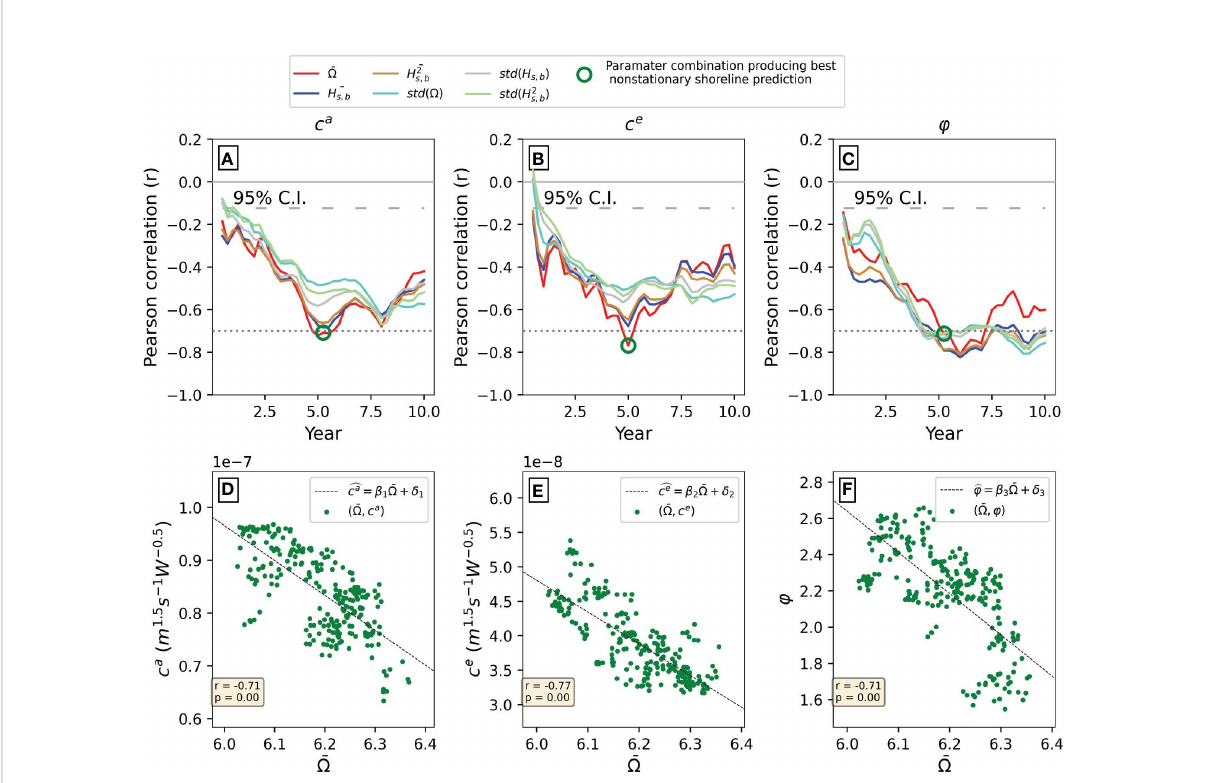
FIGURE 4 Summary results from Step 2 (Correlation analysis) and Step 3 (Parameterization) for each of the three wave-driven parameters ( c a , c e and j , left to right). Upper panels (A-C) show the Pearson correlation coef fi cient (vertical axes) for different wave climate covariates (coloured lines, see legend) at different averaging windows (horizontal axes). Horizontal and dotted black lines indicate the cut-off magnitude for strong correlations (|r|>0.7). Green open circles (panels a-c) indicate the time-window and wave climate covariate combination (here W at roughly ~5 years for all three parameters) resulting in the best shoreline prediction (using Equation 1) during the P2 period. Lower panels (D-F) show the data and linear parametrizations (Equation 3) resulting from the best non-stationary shoreline